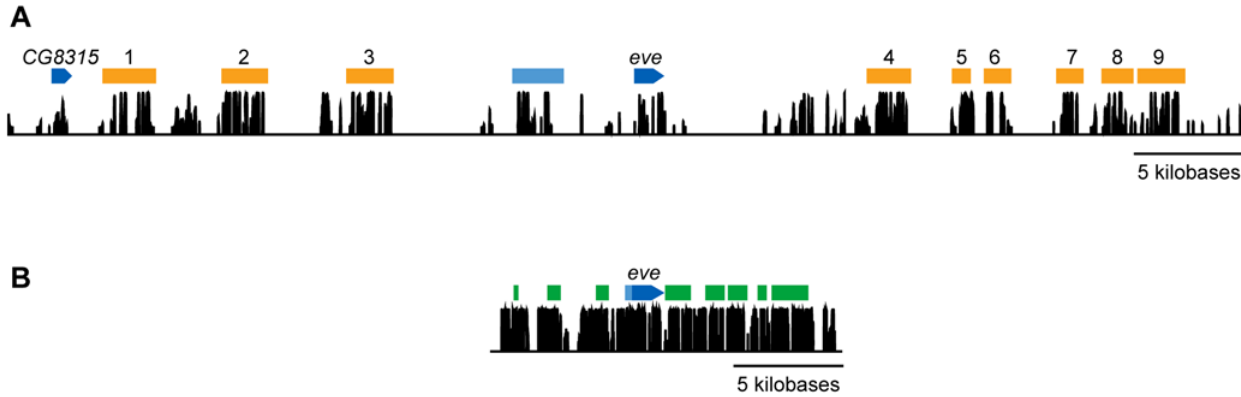
Figure 4. Landscape of sequence conservation in tephritids and Drosophila (eve). A) Phastcons [44] (version v0.9.9.6b) estimated posterior probabilities of conservation in four tephritids for 60 kb surrounding the C. capitata eve gene. Blue annotations indicate coding regions, conserved intervals are shown in orange. The interval numbers are used throughout the text. The presumptive C. capitata basal promoter is shown in light blue. B) D. melanogaster eve locus conservation plot computed with phastCons (rho 0.25) [44], rendered to scale with C. capitata plot in panel A, showing comparable highly conserved content but with virtually all intervening non-conserved DNA absent in Drosophila . Redfly enhancers listed in Figure 2 are shown in green and the basal promoter in light blue.